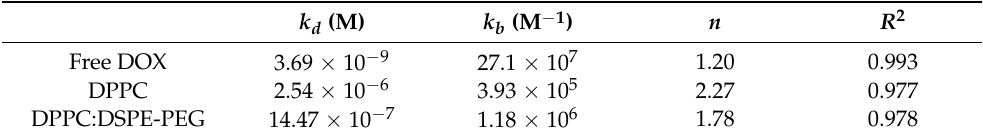
Table 6. Dissociation constant ( k d ), binding constant ( k b = 1/ k d ), and number of binding locations ( n ) of DOX, DPPC liposomes, and DPPC:DSPE-PEG liposomes to